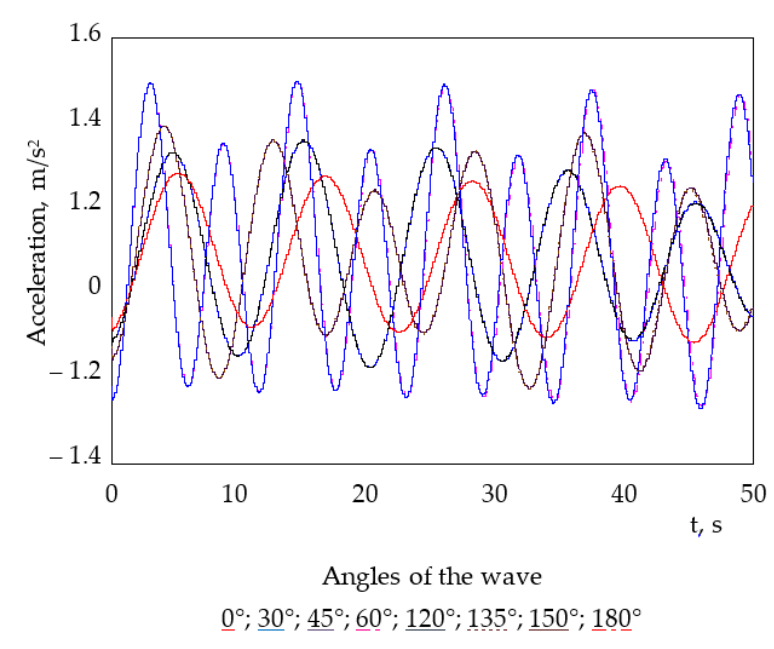
Figure 5. Accelerations applied to the container during transportation on a railway ferry.